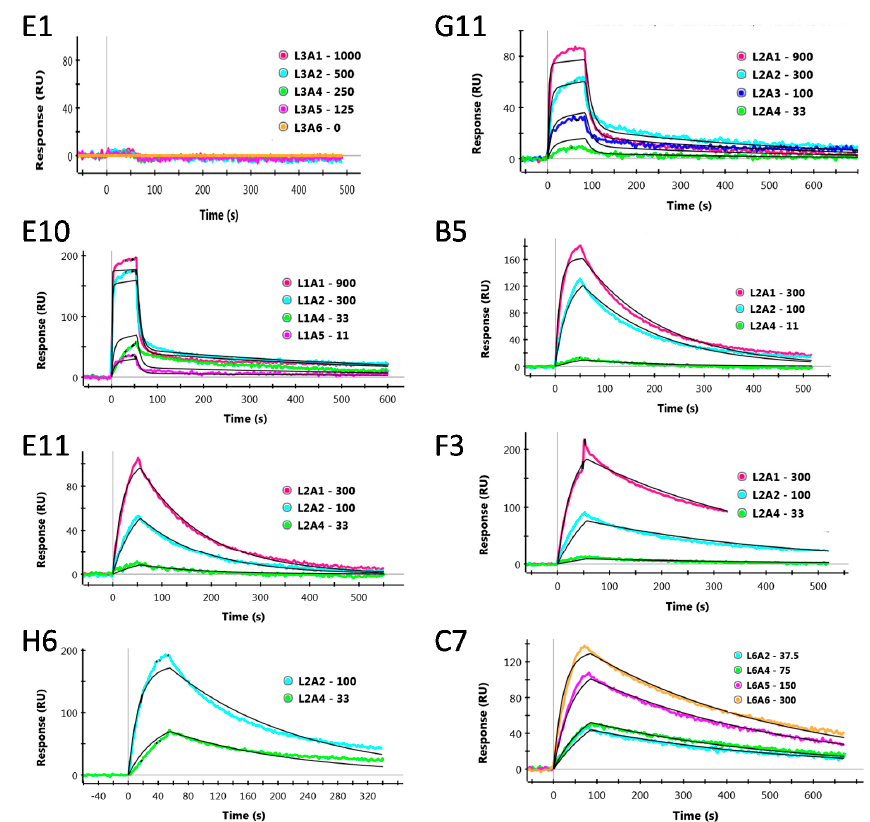
Figure A1. Representative surface plasmon resonance data for each of selected Lassa NP binding sdAb. The data for each clone is presented to the right of it’s name, in order from top to bottom, and left to right, clone E1, G11, E10, B5, E11, F3, H6, and C7.